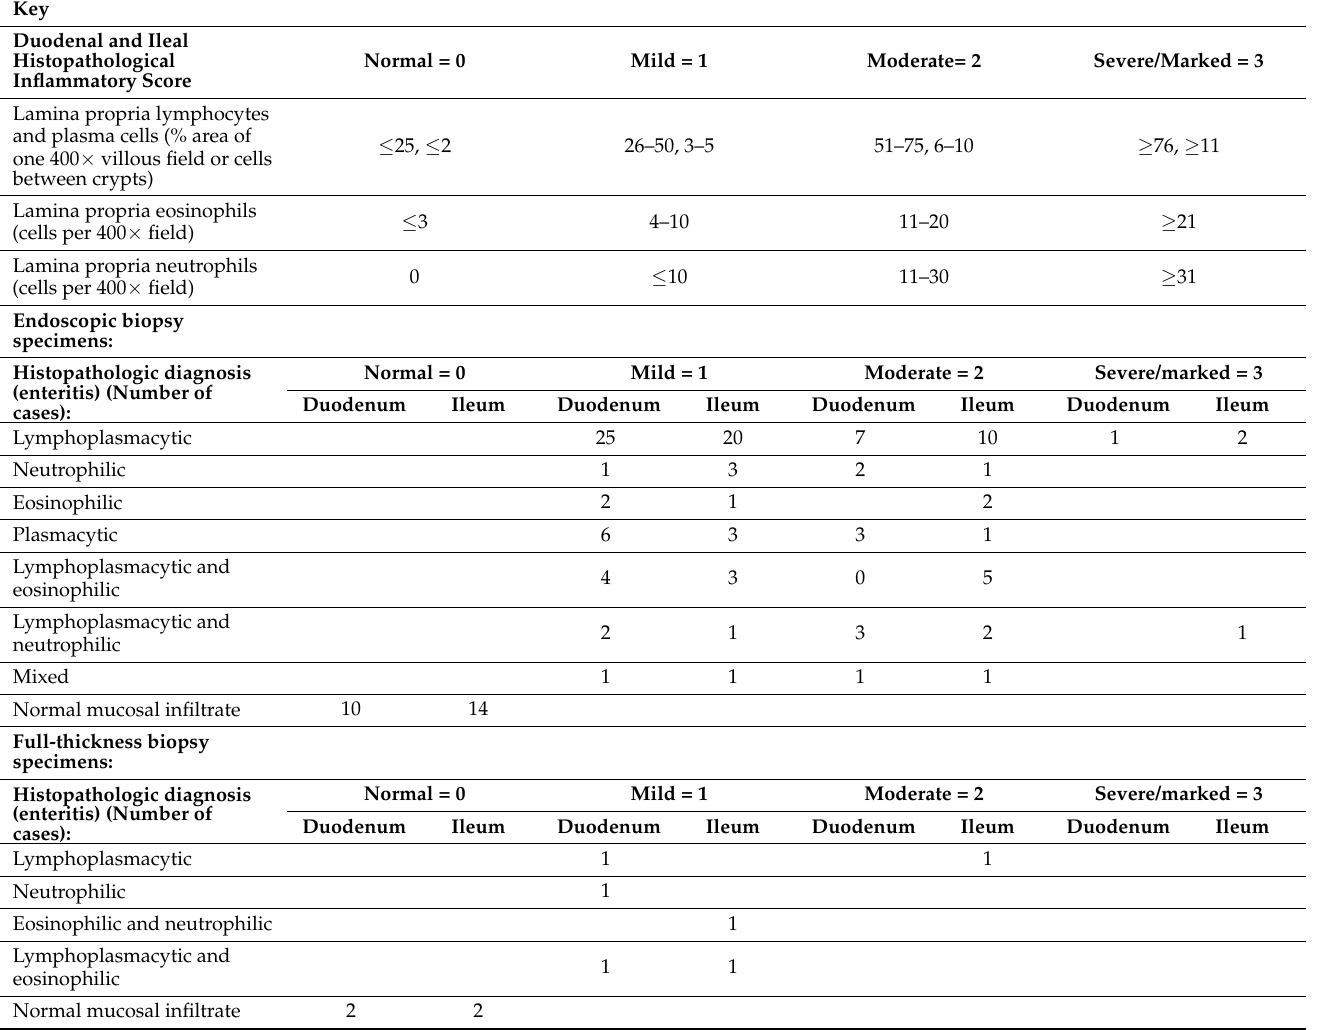
Table 3. Final histopathologic diagnosis at both the duodenal and ileal sites for chronic inflammatory enteropathy cases depicted with the inflammatory score. The numbers within the table represent the number of cases that had this final diagnosis at the individual location. This table depicts both endoscopic biopsy cases (74 dogs) and full-thickness biopsy cases (5 dogs). The key explains the definitions for each inflammatory score based upon inflammatory infiltrate type. Adapted from Allenspach et al., 2019